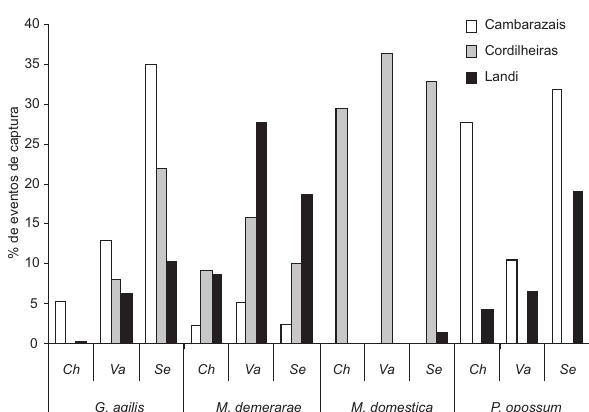
Figura 1. Freqüência relativa dos eventos de captura para cada espécie em cada da fisionomia na cheia (Ch), vazante (Va) e seca (Se), a partir dos dados mensais dos anos de 2006 e